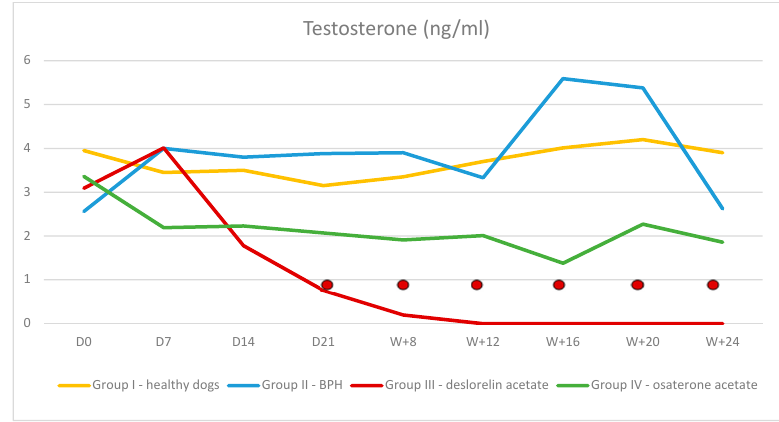
Figure 5. Concentration of testosterone in Control I and II and Treated III and IV Groups of dogs during 24 weeks of the trial (mean, SD). —indicates p < 0.01 compared to D0 in Group III.